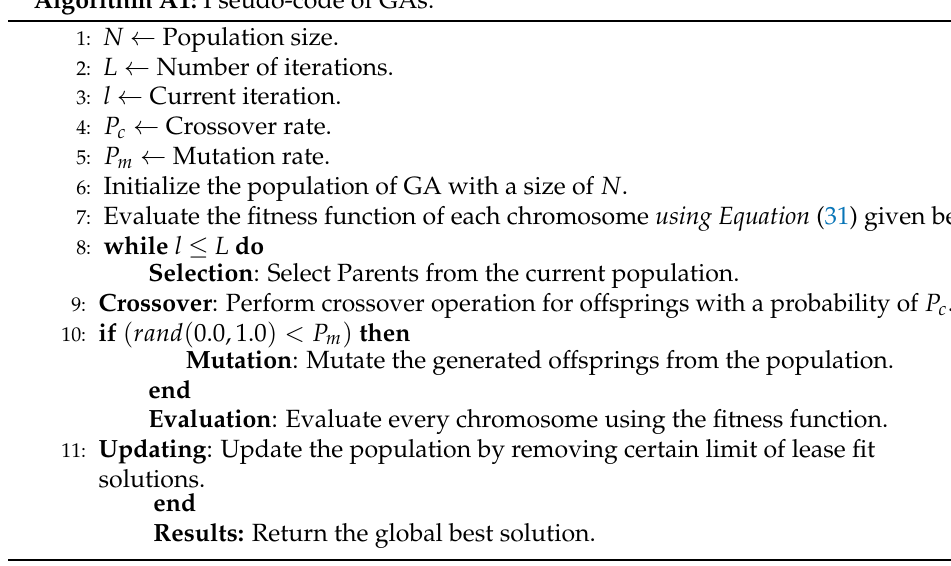
Algorithm A1: Pseudo-code of